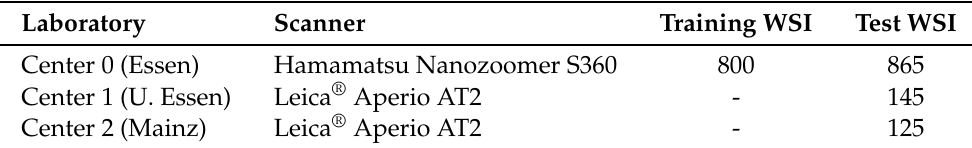
Table 1. Sources of training and test data included in the study. In total, 1935 WSIs were analyzed.